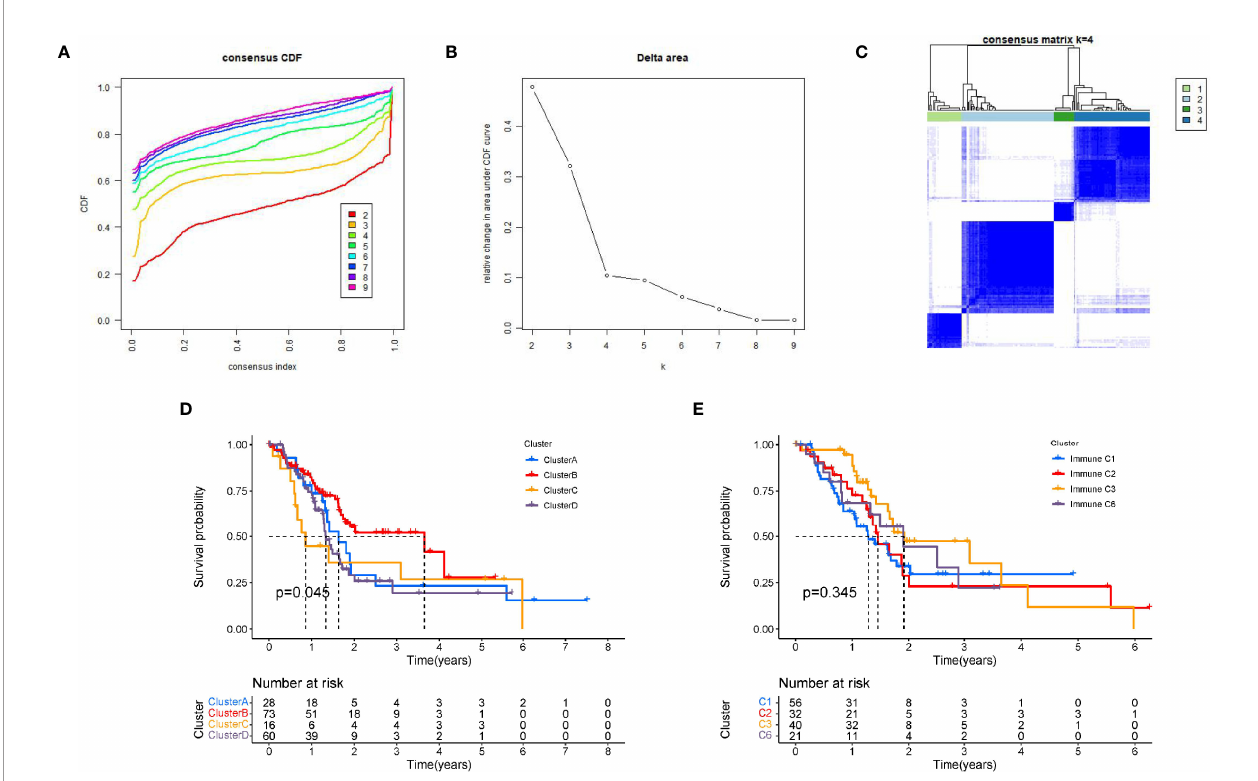
FIGURE 2 | Tumour classi fi cation based on the prognostic PRGs. (A) The relative change of the area under the CDF curve from 2 to 10 of k. (B) The consistency clustering cumulative distribution function (CDF) when k is between 2 and 10. (C) At k=4, the correlation between groups. (D) Kaplan-Meier survival analysis among four clusters. (E) Kaplan-Meier survival analysis among immune subtypes reported in prior